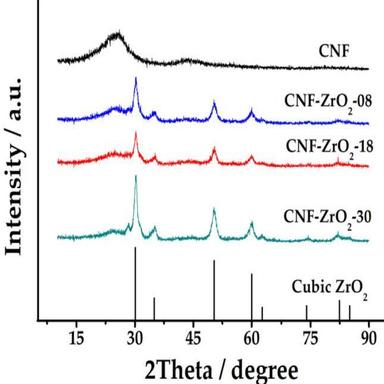
SEM images of CNF (a, b), CNFeZrO2-08 (c, d), CNFeZrO2-18 (e, f), and CNFeZrO2-30 (g, h) samples.